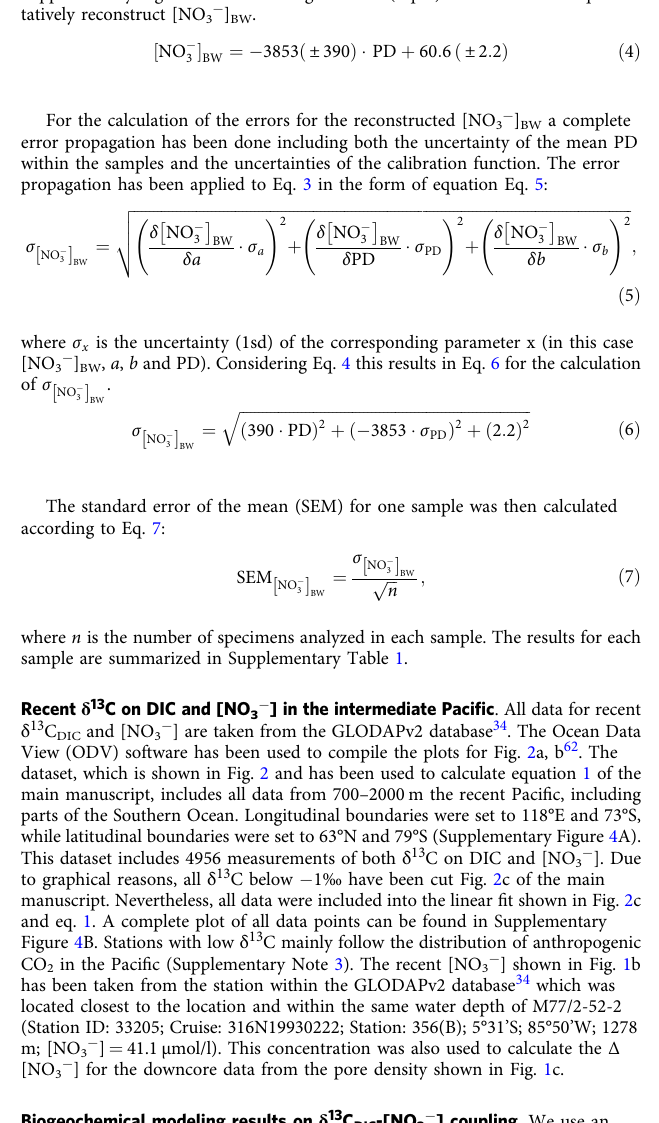
Supplementary Figure 6. The resulting function (Eq. 4) has been used to quanti- tatively reconstruct [NO 3 − ] BW